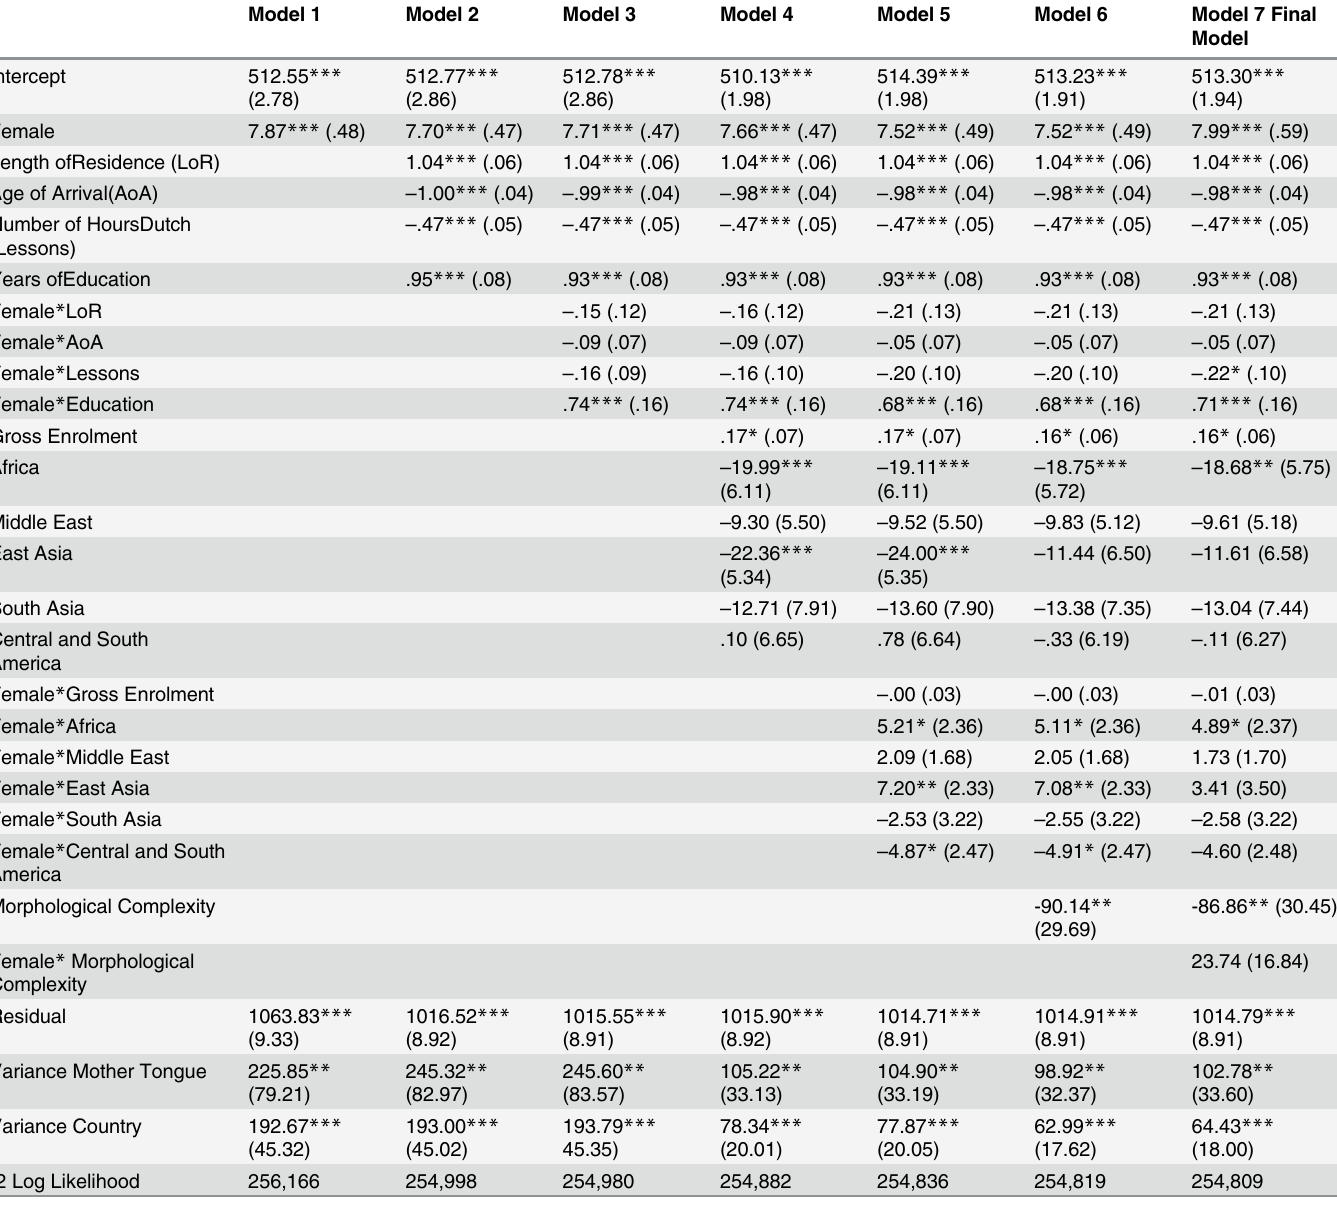
Table 2. Cross-classified Multilevel Model Parameter Estimations for Measures of the Dutch Speaking Proficiency Test (Standard Errors in Paren- theses) per Mother Tongue and Country of